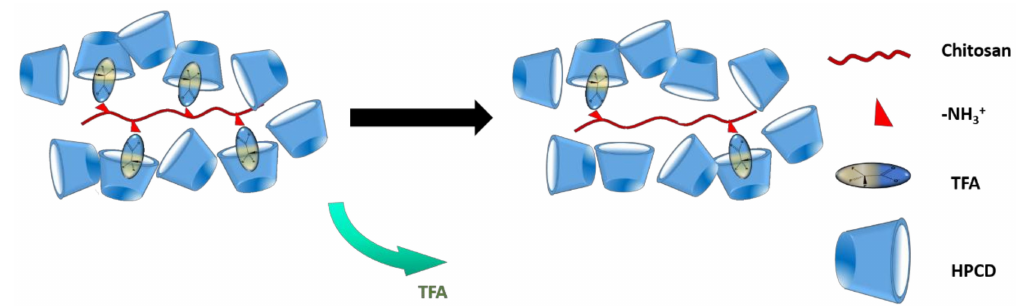
Figure S1: FT-IR spectrum ( A ) and a DTG plot ( B ) of pristine chitosan; Figure S2: 1 H NMR spectra of pure HPCD ( A ) and Chi:HPCD 2:20 fiber ( B ) prepared in 1% ( w / w ) tetrahydrofuran (THF) / DMSO- d 6 solution for HPCD content determination; Figure S3: Solid-state 13 C CP-TOSS NMR spectra of HPCD ( A ), Chitosan ( B ) and Chi:HPCD ( C ) 2:50 fiber (from top to bottom,